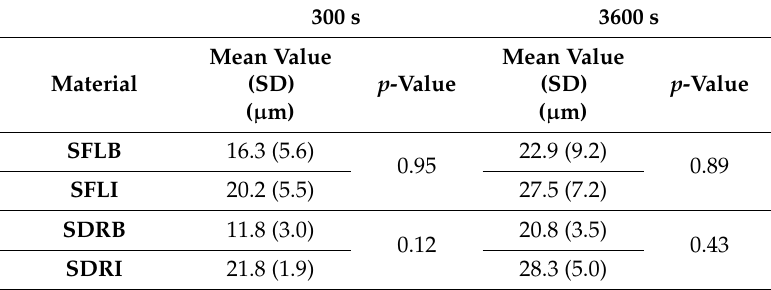
Figure 3. Simultaneous time measurements of cuspal distance variation, temperature, and photodiode signal for MOD cavities restored with SonicFill 2. The photodiode signal is reported on an arbitrary scale and it was used to detect the light curing and the dark reaction phases. MOD cavities restored according to ( a ) the bulk-fill technique and ( b ) the incremental technique. Table 4. Cuspal distance variation at 300 s and at 3600